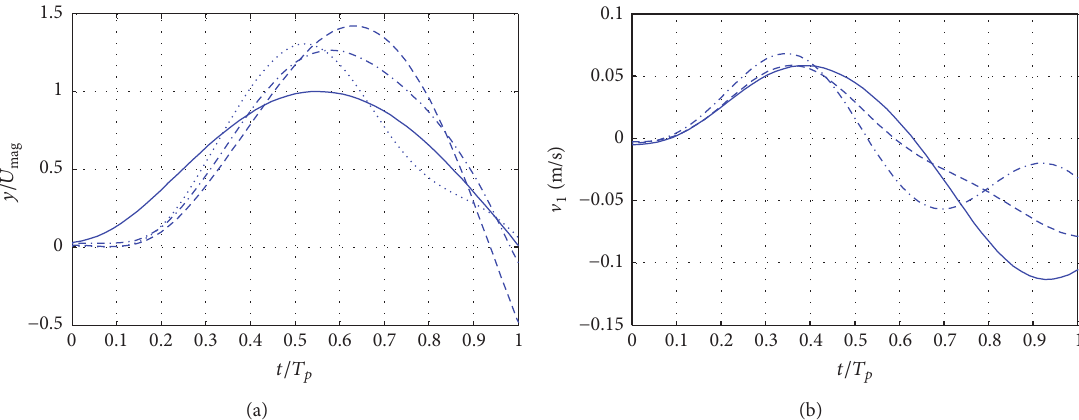
Figure 24: (a) Comparison between measured displacement responses at the end of the primary beam with different levels of friction for the case of the thin secondary beam. (b) Comparison between measured velocity responses at the end of the primary beam with different levels of friction for the case of the thin secondary beam. Solid line: base input. Dashed line: no friction. Dash-dotted line: intermediate friction. Dotted line: high friction.